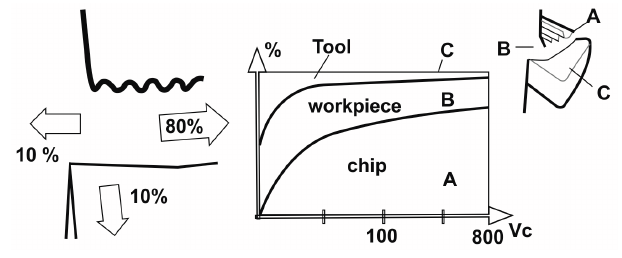
Figure 1. The balance of heat generation and heat dissipation in metal cutting